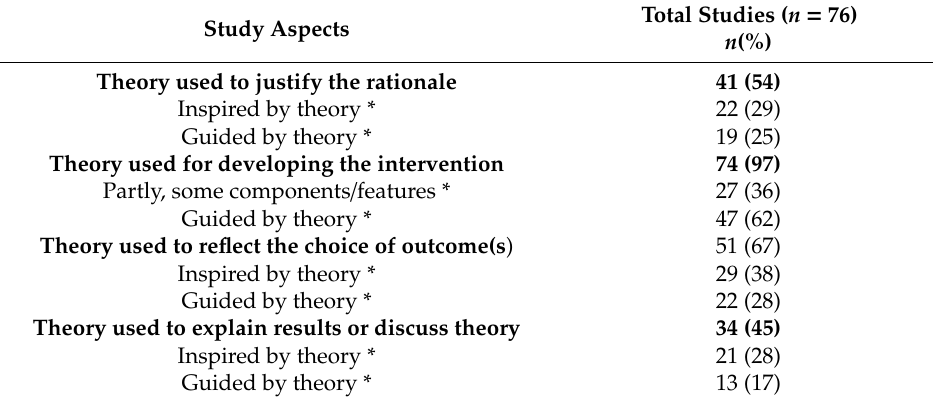
Table 4. Use of theory in the rationale, intervention, outcomes, and